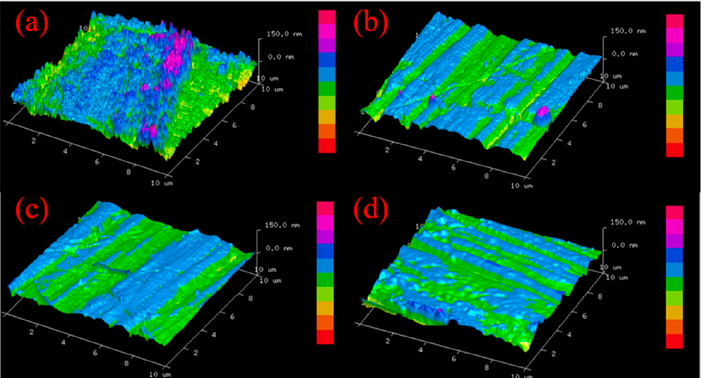
Figure 10. AFM image of unpolished brass workpiece surface ( a ) and three different positions of brass workpiece surfaces ( b – d ) polished for 2 h by alumina-doped titanium dioxide ER polishing fluid (rotation speed = 200 r/min, voltage = 3 kV, machining gap = 0.5 mm).